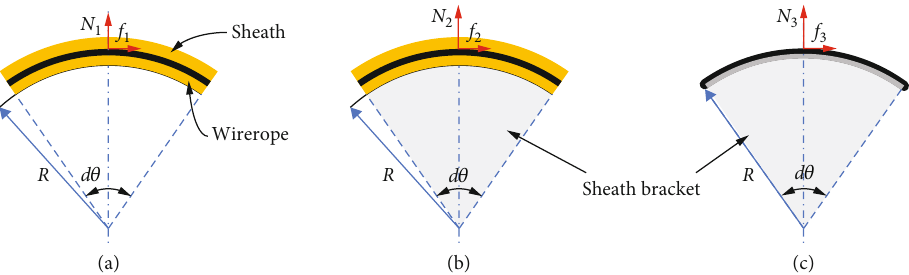
Figure 4: The three sketches of the friction and pressure of Bowden cable. (a) The friction of Bowden cable in free state. (b) The friction of Bowden cable in extrusion state. (c) The friction between the wire rope and sheath bracket 2.